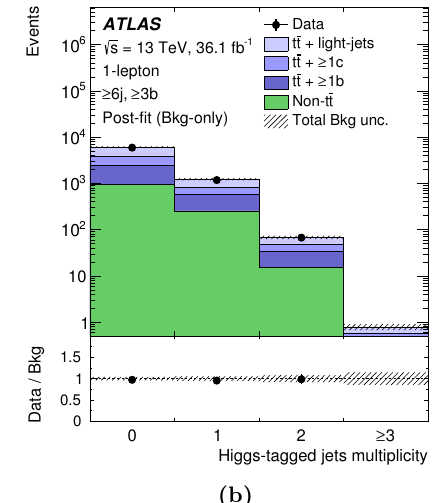
6 jets and 3 b -tagged jets, (a) (cid:21) (cid:21) 1 b background is (cid:21)